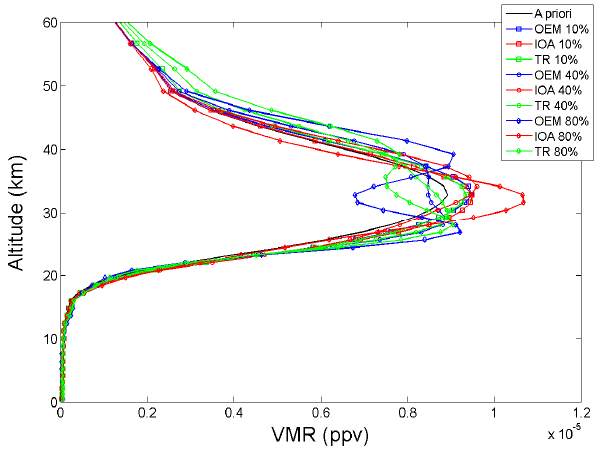
Fig. 13. O 3 profile on 12 June 2007 at St.-Denis obtained when using S a with on its diagonal 10% (squares), 40% (circles) and 80% (diamonds), retrieved with the OEM (blue), IOA (red) and TR (green), respectively. The black profile is the unchanged a priori profile.